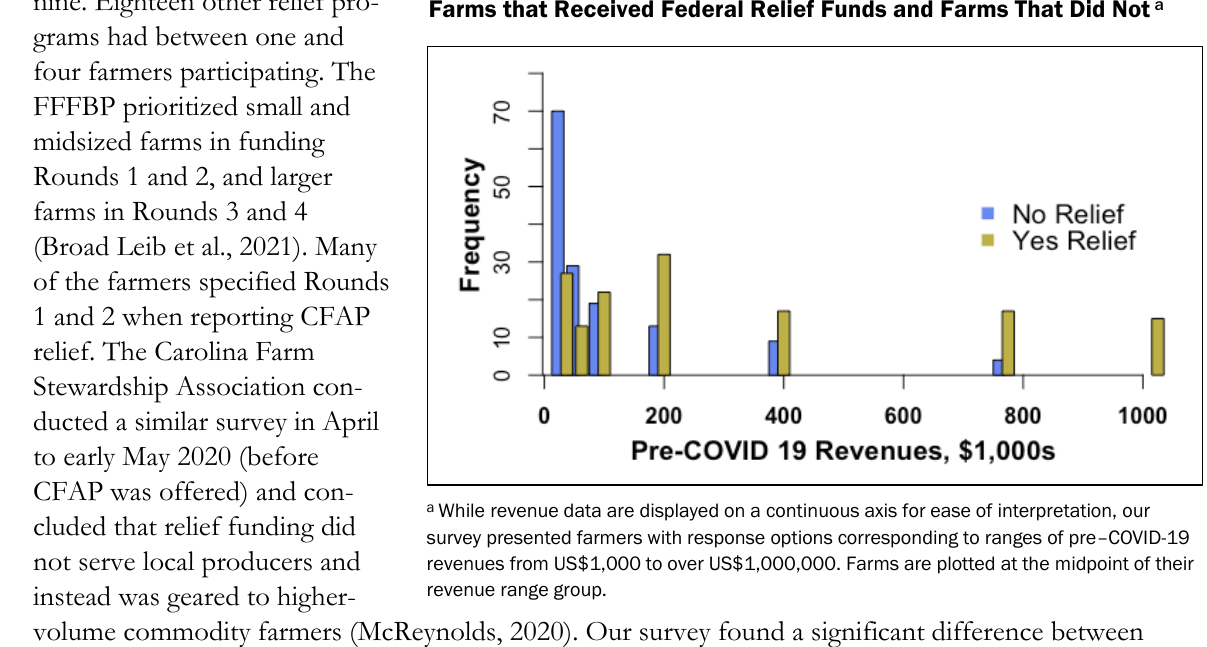
Figure 3. Typical Pre – COVID-19 Annual Revenues for